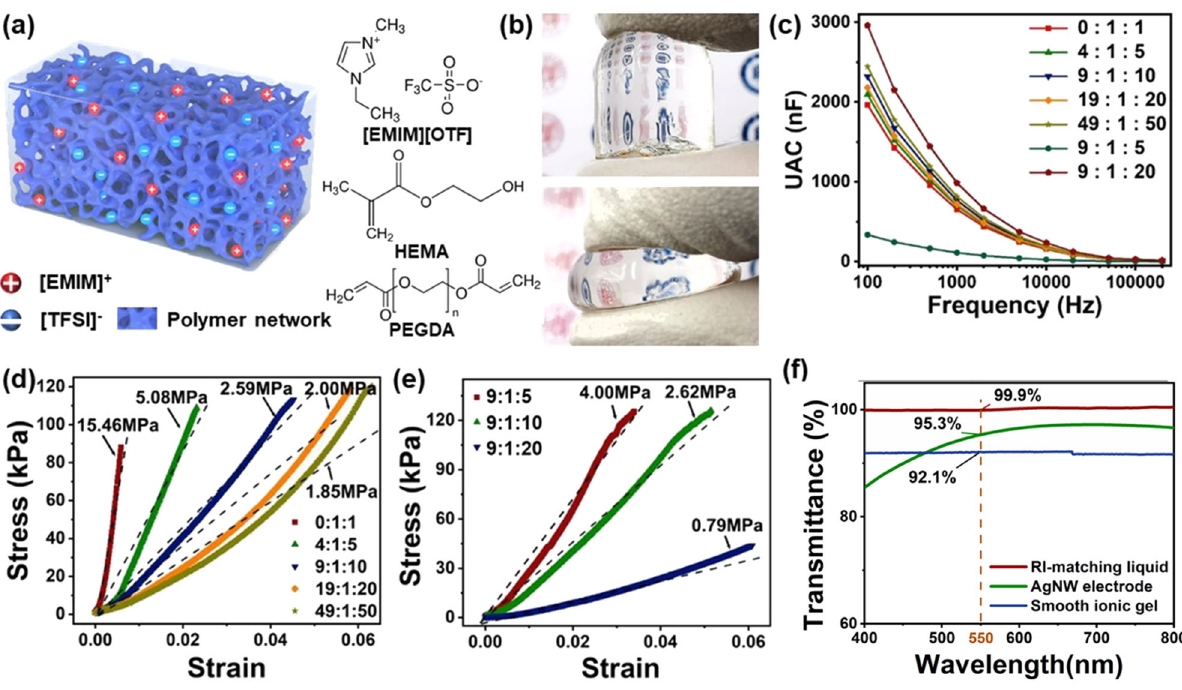
Fig. 2 The performance of the ionic gel for TIS device. a The molecular structure of the ionic gel, b the photos of the ionic gel indicating its high elasticity, c the UACs of the ionic gels with different compositions, d the Young ’ s modulus of the ionic gels with different crosslinking densities, e the Young ’ s modulus of the ionic gels with different ionic liquid concentrations. The inserted ratios in c – e are the weight ratio between HEMA, PEGDA, and [EMIm]OTf. f The visible spectrums of all the building materials of the TIS devices, which include the ionic gel, AgNw conductive fi lm, and RI-matching